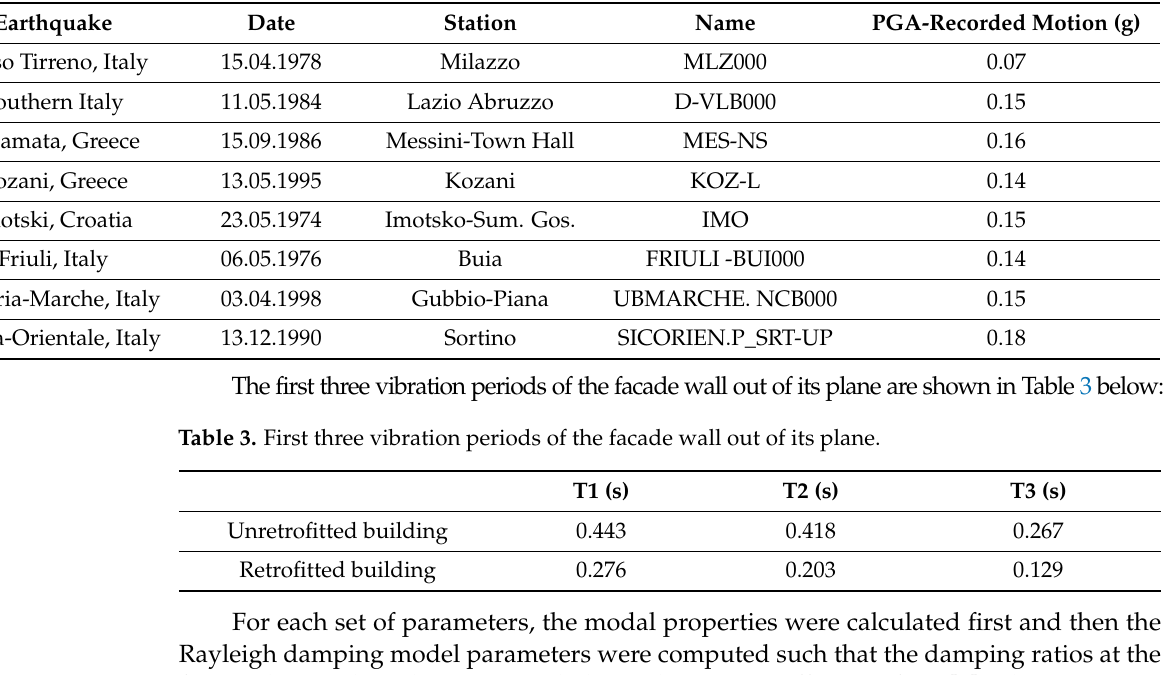
Table 2. Ground motion ensemble used for the Incremental Dynamic Analysis.